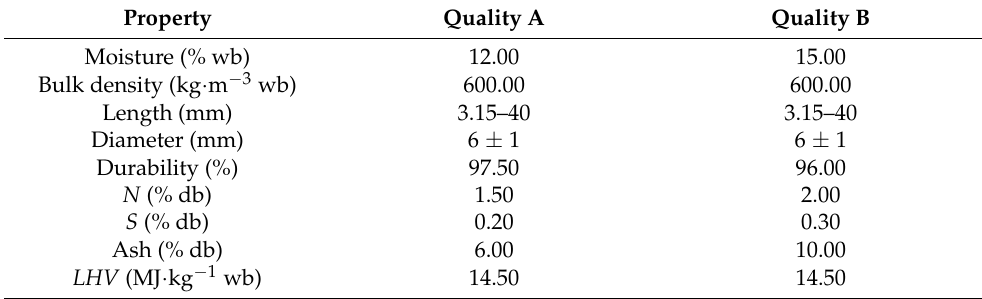
Table 1. Principal specifications of quality from nonwoody pellets. LHV , low heating value.